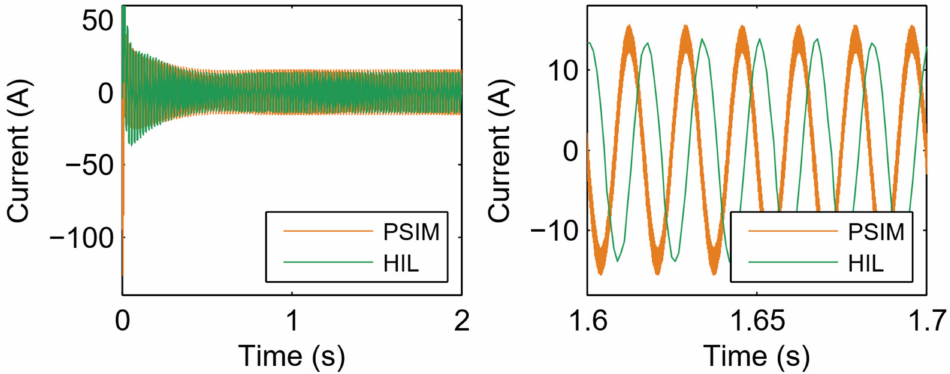
Figure 24. i a response under closed loop and rectifier mode conditions.